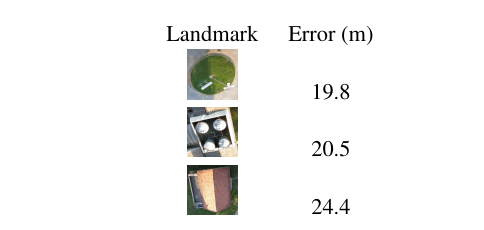
Figure 3. Result for the indirect Geo-referencing of a frame. The green dots are the real position and the red dots are the estimated position.